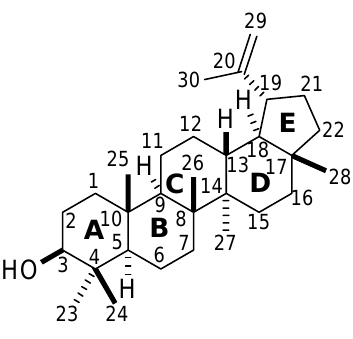
Figure 1. Chemical structure of